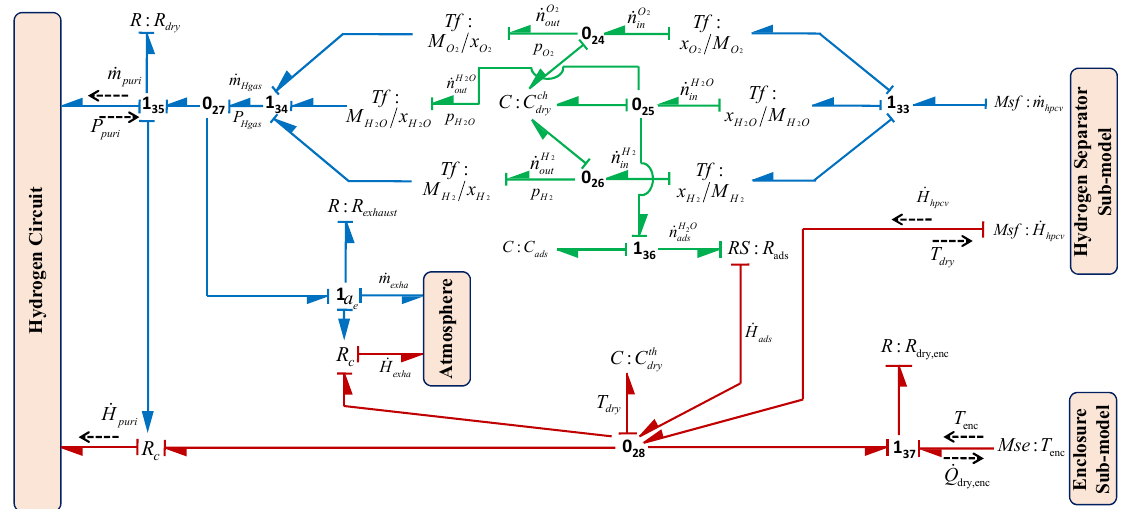
Figure 17. BG sub-model purification subsystem in capsule form.